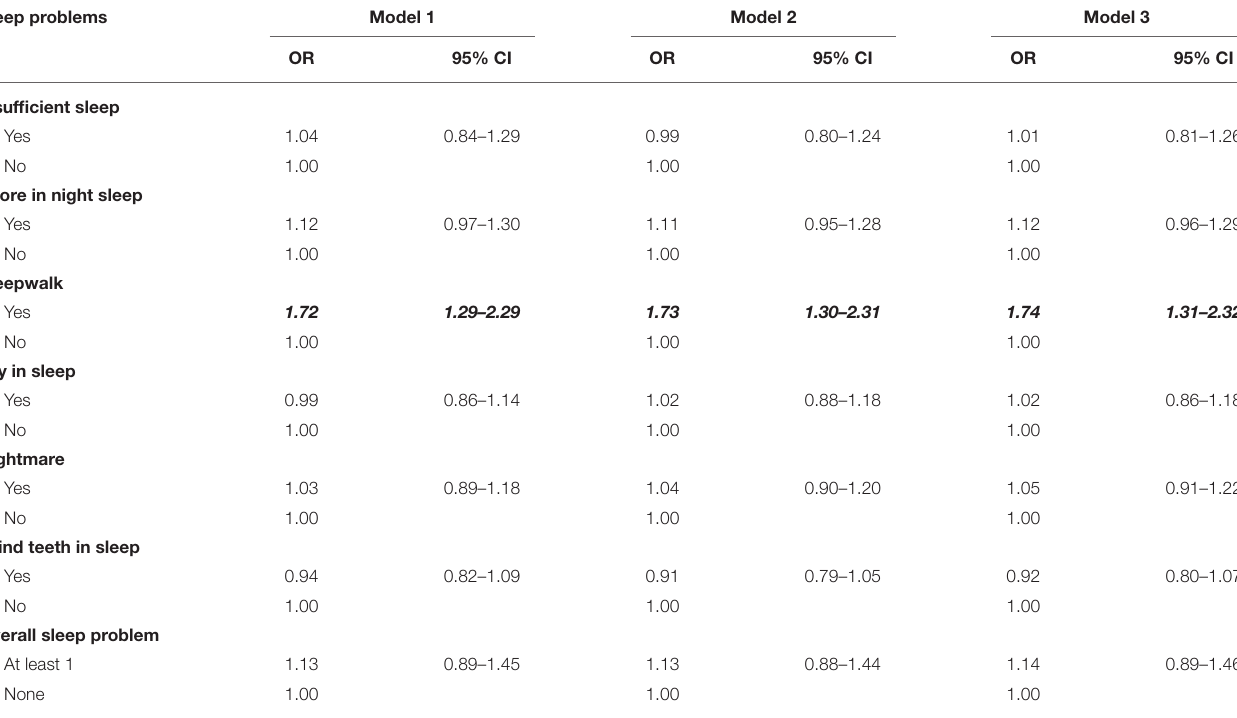
TABLE 3 | The association between preterm birth and each sleep problems among kindergarten children aged 3 to 6 years in a rural area of Shanghai,